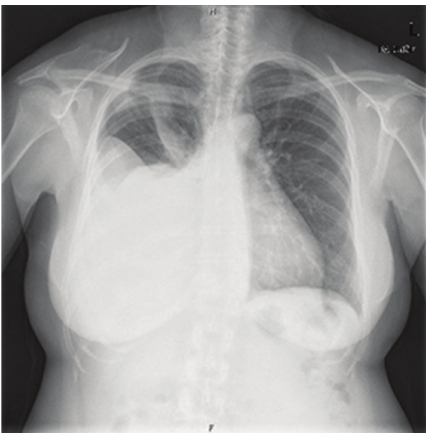
Figure 1: Chest scan with a large pleural e ff